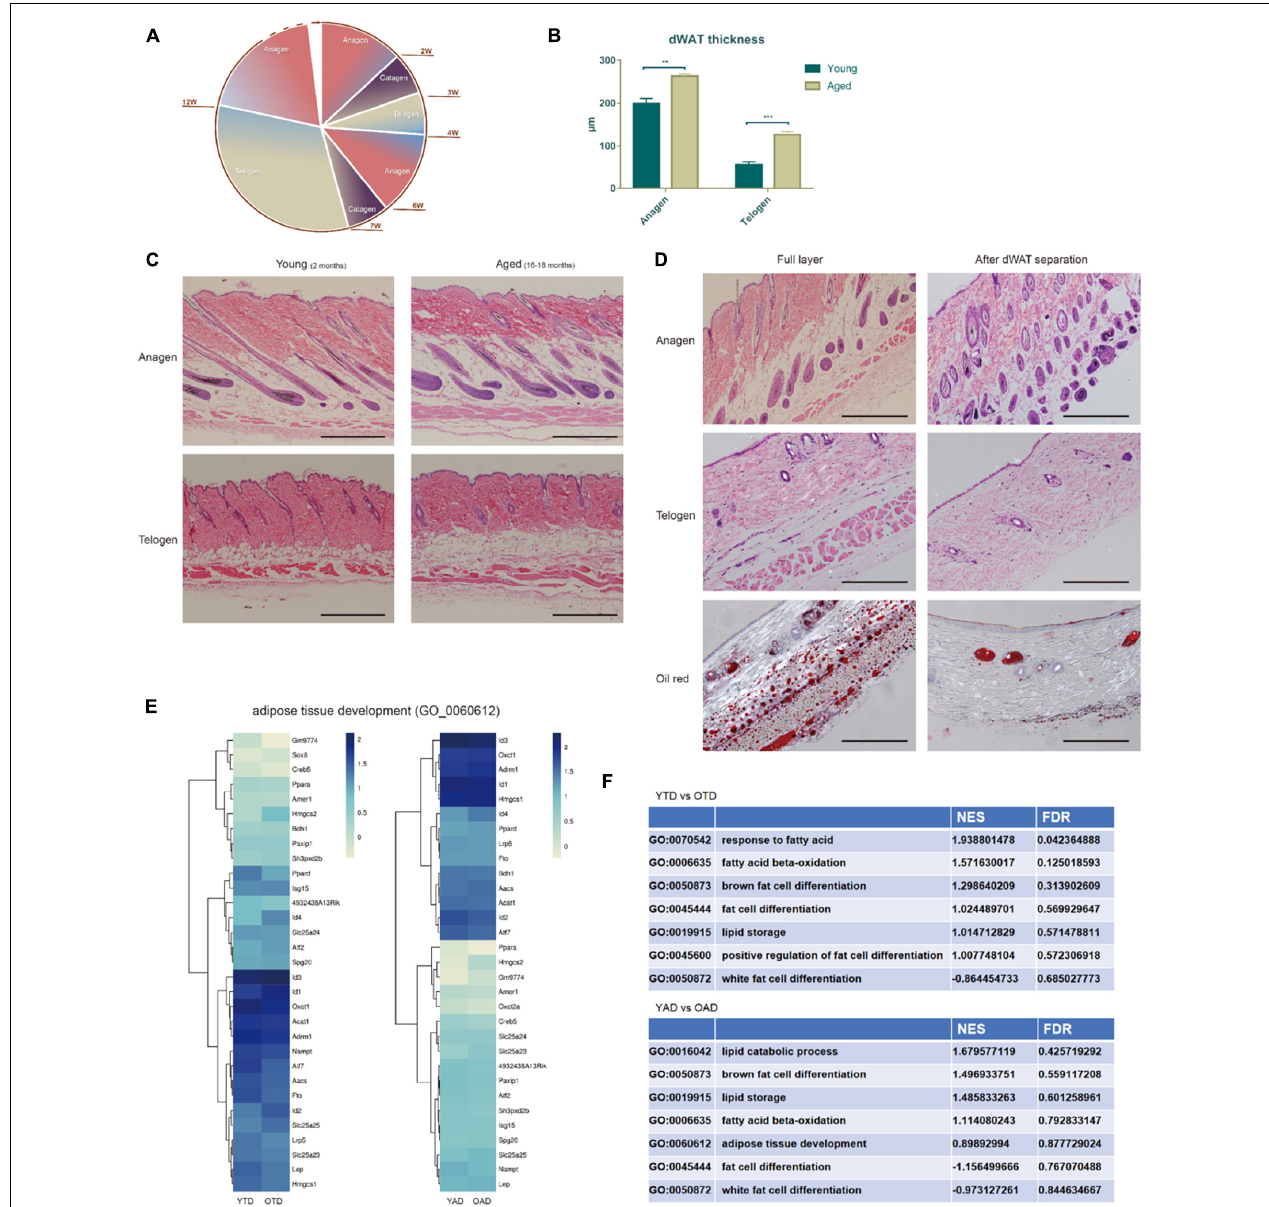
FIGURE 1 | Aging dWAT undergoes structural remodeling with HF defective growth. (A) Decelerated hair cycling with aging. (B,C) dWAT thickness significantly increased with aging. Comparing to young mice, the dermis thickness decreased while the dWAT thickness increased at both anagen and telogen in aged mice. ** P < 0.01, *** P < 0.001. n = 10 (D) By microdissection, the subcutaneous adipose tissue and panniculus carnosus were in turn removed, and dWAT was then harvested by slightly scraping from the bottom of HFs. (E) Unsupervised clustering of OAD/YAD, OTD/YTD samples based on GO signature—adipose tissue development. No significant difference was indicated between each comparison. Dark blue represents high expression level and yellow represents low expression level. (F) GSEA analysis of adipose-related terms all exhibited no significant enrichment. All terms’ FDR exceeds 0.05. NES, Normalized Enrichment score. FDR, False discovery